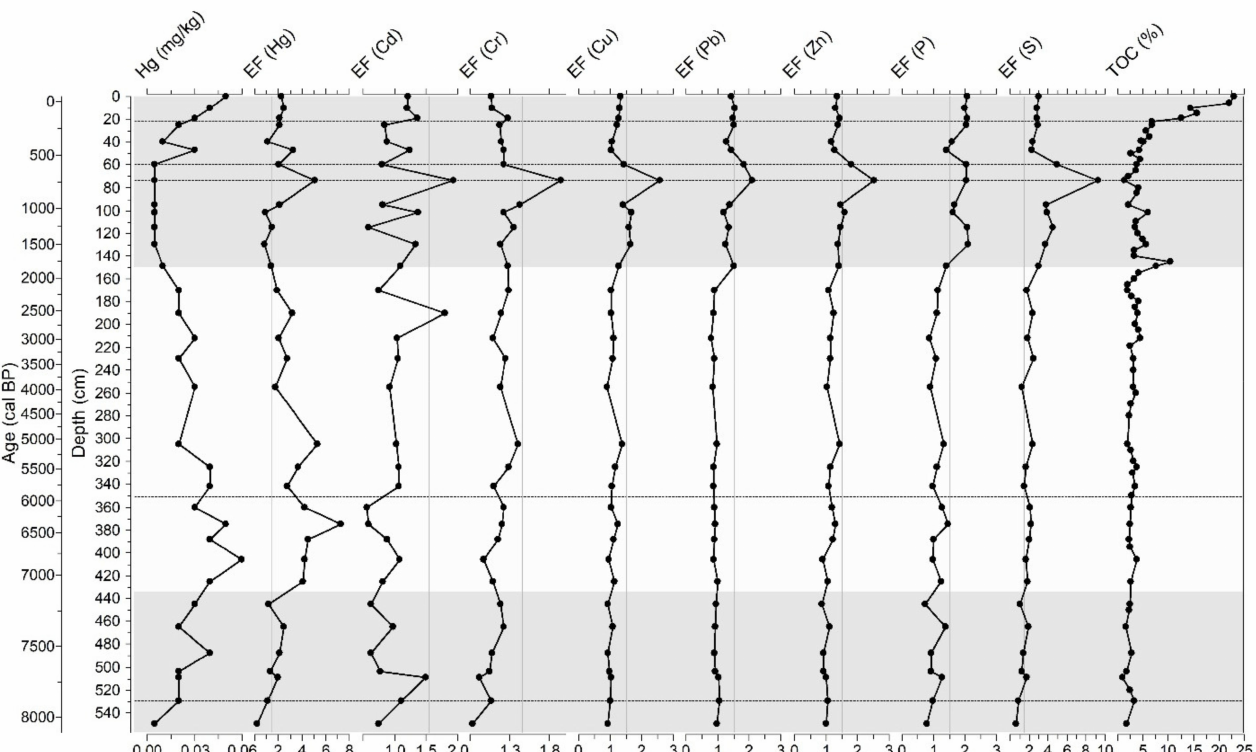
Figure 15. Enrichment factors (EFs) for Hg, Cd, Cr, Cu, Pb, Zn, P, and S, as well as concentrations of Hg and TOC in the sediment core from Velo